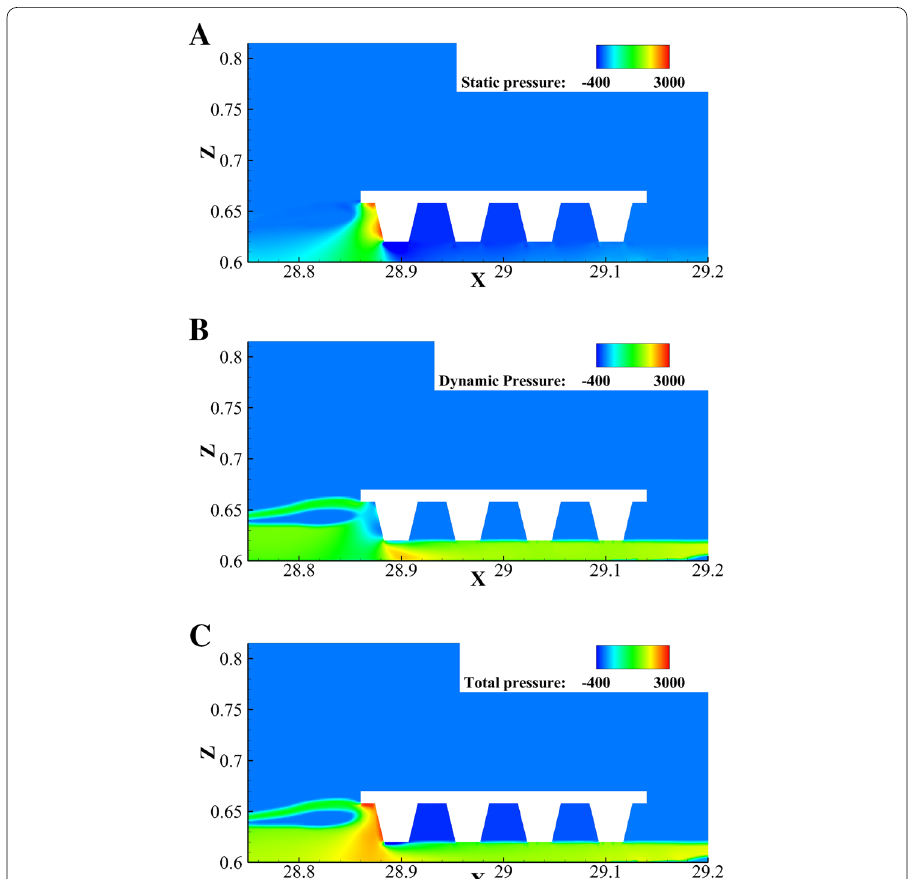
Fig. 14 Static pressure ( a ), dynamic pressure ( b ) and total pressure ( c ) at t pressure: